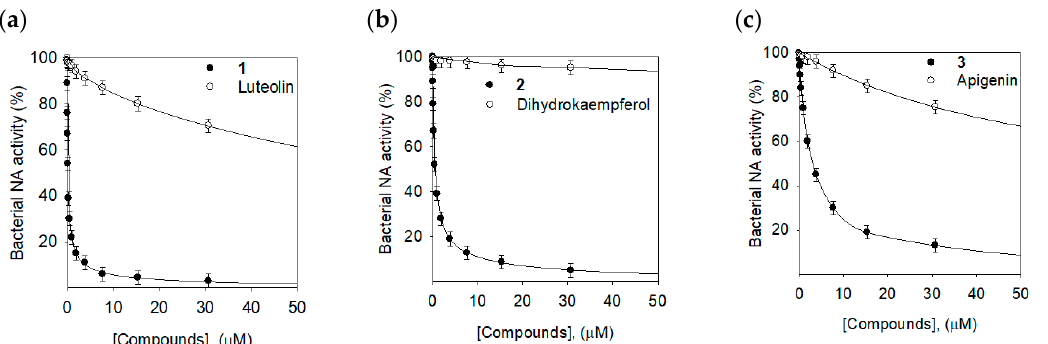
Figure 3. Effectiveness of the prenyl group on the bacterial neuraminidase inhibitory activity. ( a ) compound 1 versus luteolin, ( b ) compound 2 versus dihydrokaempferol, and ( c ) compound 3 versus apigenin.